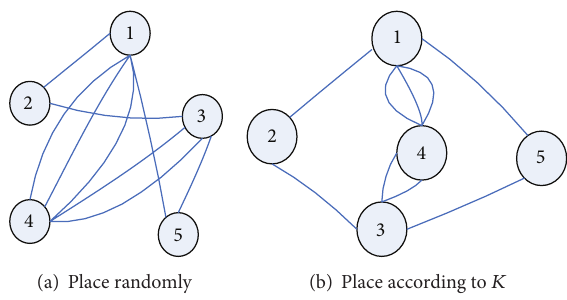
Figure 1: The influence of the subgraphs’ positions on cross-edges.